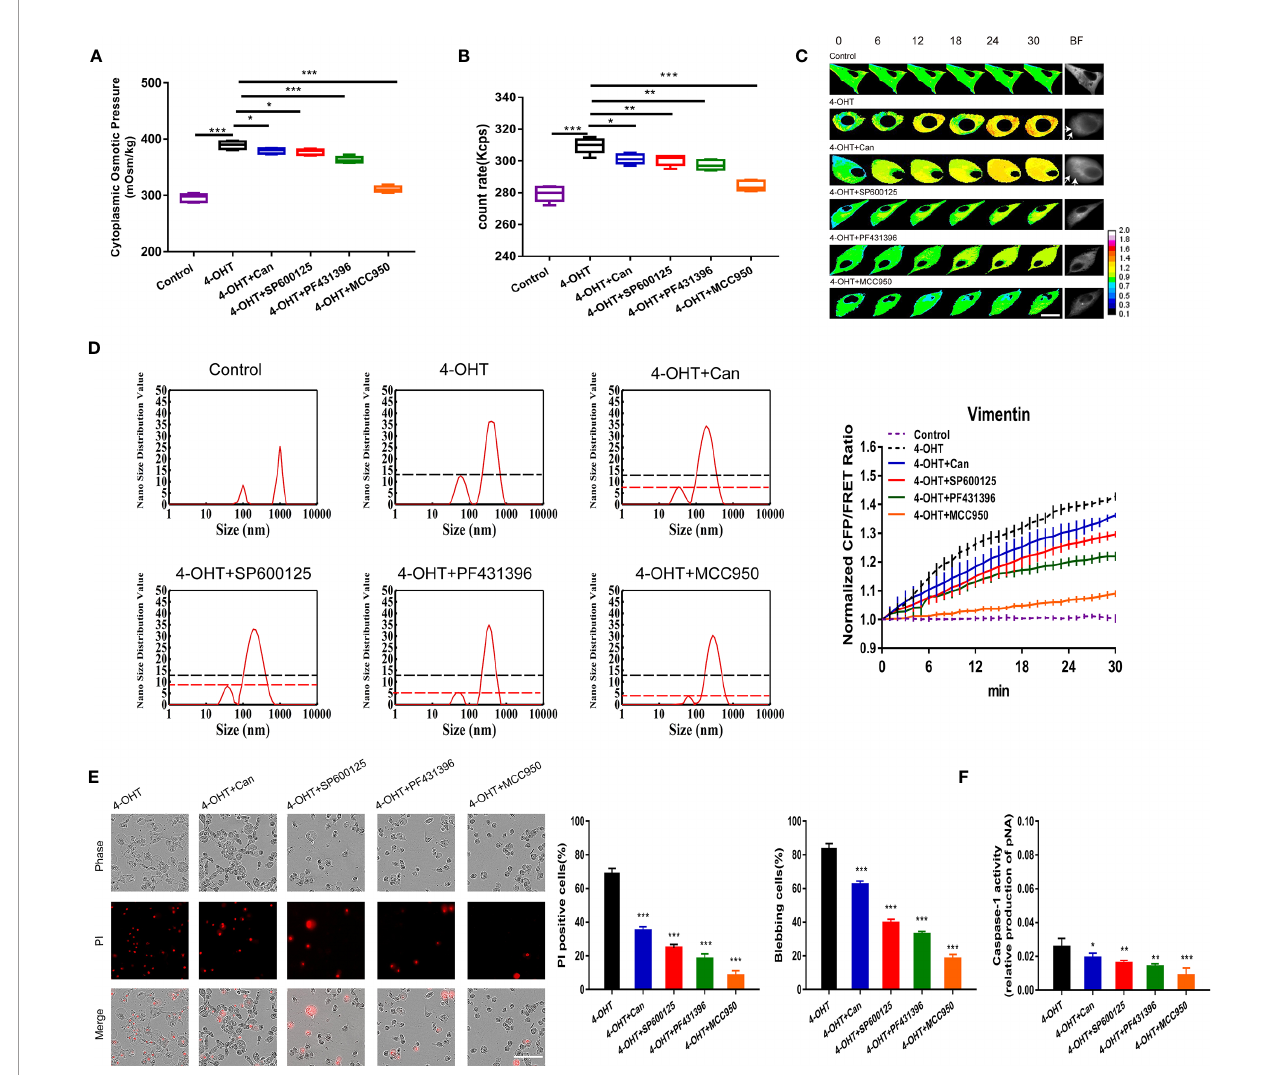
FIGURE 3 | Blockade of NLRP3 assembly and activation downregulated PN-OP and inhibited pyroptosis. (A) The cytoplasmic OP values of U87 cells were measured using a freezing point osmometer under co-treatments of 4-OHT with cantharidin (10 m M), SP600125 (20 m M), PF431396 (15 m M), or MCC950 (1 µM), respectively. (B) The count rate of PNs in U87 cells. (C) Representative images and mean values of normalized CFP/FRET ratios of Vimentin tension under the different treatments. Arrows indicate the membrane blebbing regions. (D) Nano size distribution of protein granules in the cytoplasm. (E) Representative time ‑ lapse images of U87 cells. Cell membrane integrity was monitored by PI uptake (red fl uorescence). The bar charts represent cells showing PI positive and blebbing. (F) Caspase-1 activity of cells. Mean of ≥ 3 experiments ± SEM. Values marked with asterisks are signi fi cantly different, as determined using a t